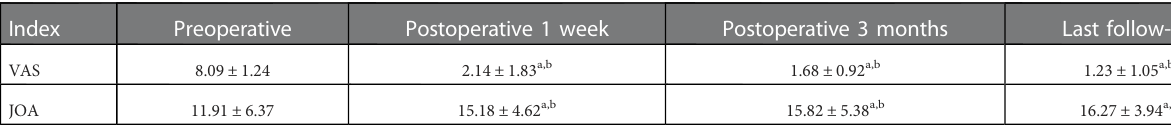
TABLE 2 Comparison of VAS and JOA before and after operation.